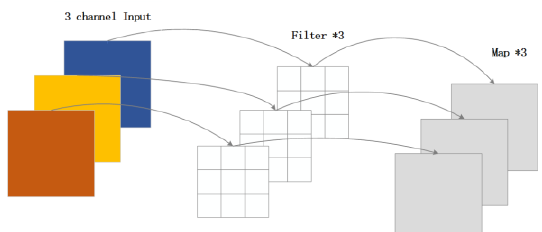
Figure 11. Depthwise Convolutional